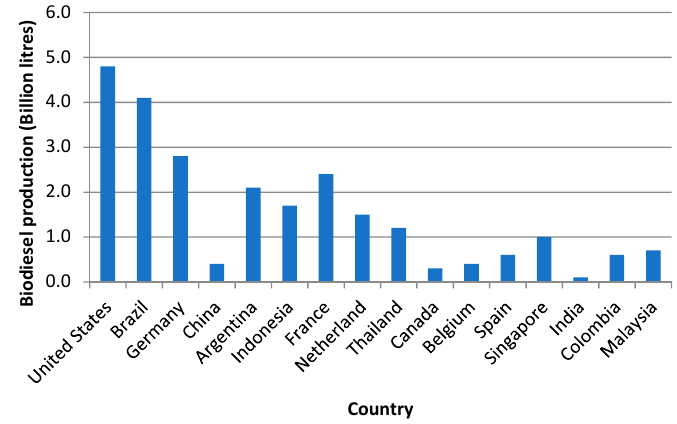
Figure 3. The biodiesel global production of the top 16 countries in 2015 [20].